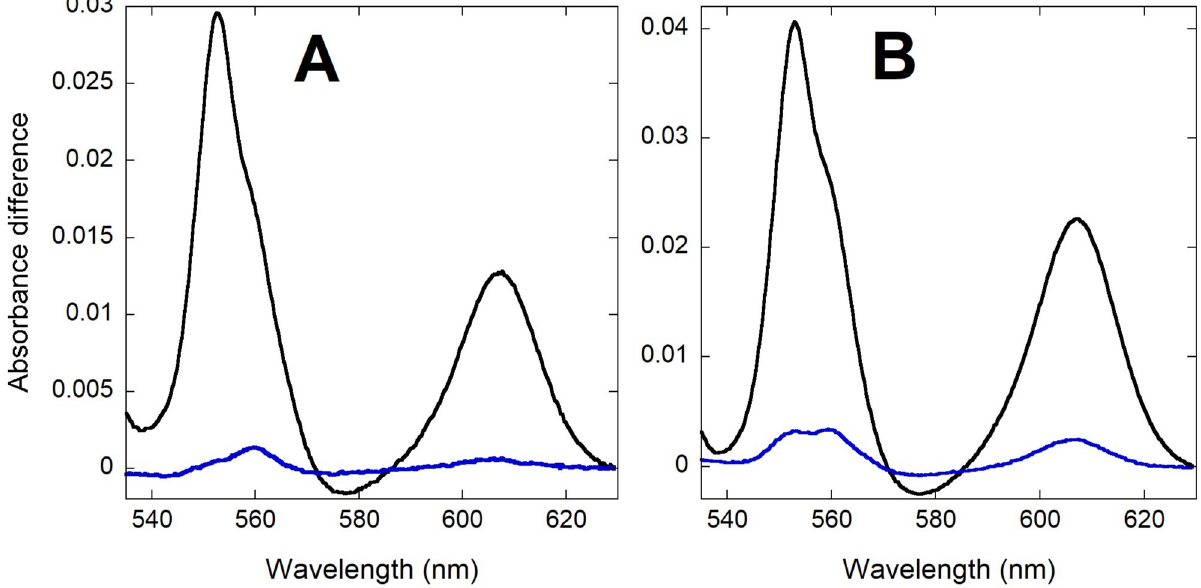
Fig 7. Comparison of the magnitude of cytochrome absorbance changes induced by the addition of KCl (blue) relative to the full absorbance scale observed at anoxia (black). CyoB - /CcoN - K + -depleted cells respiring on glucose (A; 3.25 x 10 10 cells/ml) or sodium malate (B; 5.41 x 10 10 cells/ ml) were used to collect difference spectra calculated relative to incubation before substrate. 400 spectra collected every 0.5 s were averaged for each condition and the resulting averaged spectra were subtracted as indicated (KCl-substrate or